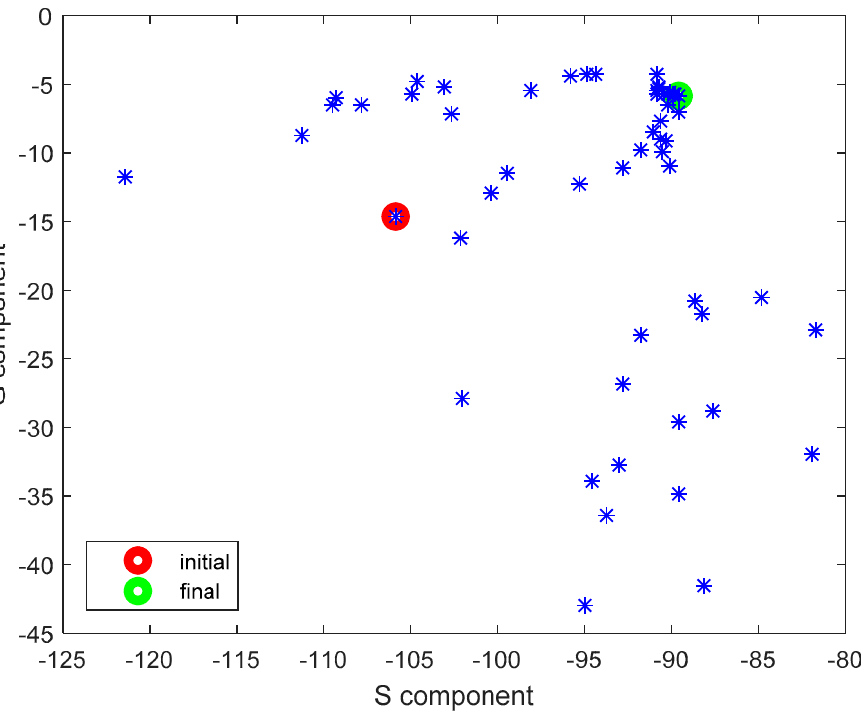
Figure 10. The history of the optimization process in the objective function space.